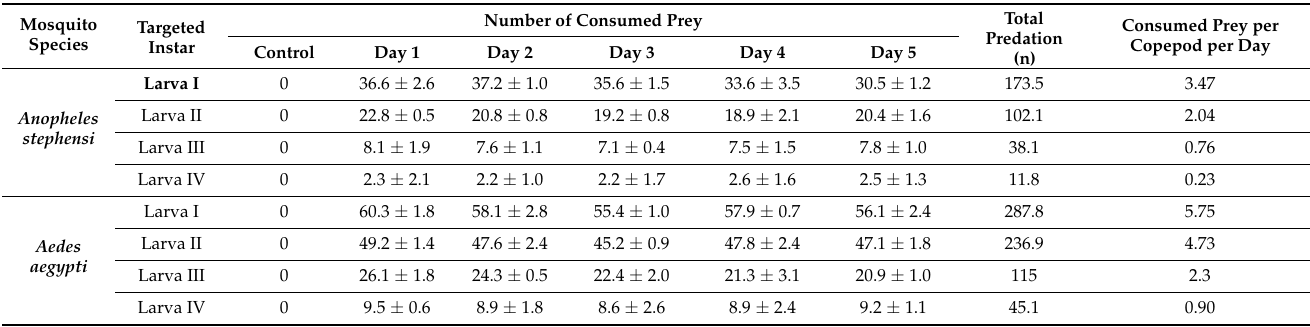
Table 1. Predation efficiency of the copepod Mesocyclops aspericornis against larvae of Anopheles stephensi and Aedes aegypti .